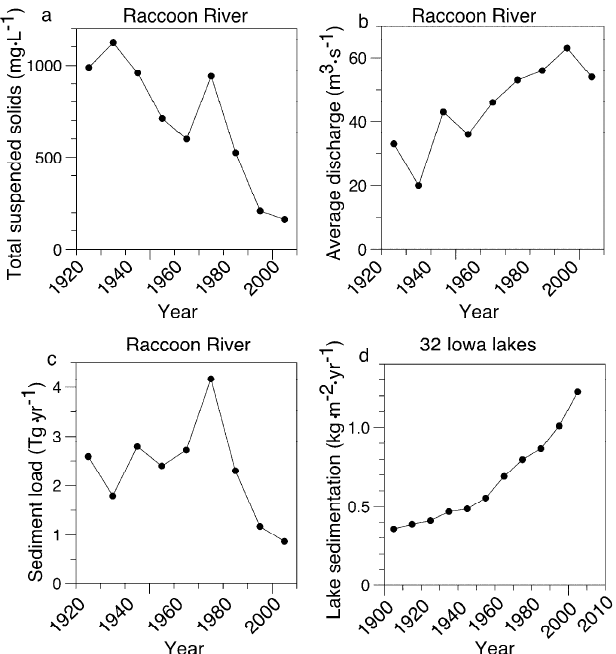
Figure 5. Decadal averages for total suspended solids ( a ), discharge ( b ) and sediment loads ( c ) (1 Tg = 10 12 grams) from 1916 to 2009 in the Raccoon River, Iowa. Data are from Jones and Schilling [20]. Decadal geometric means for lake dry sediment accumulation rates ( d ) based on 210 Pb dating of sediment cores from 33 Iowa lakes using data from Heathcote et al. [11]. Table 3. Estimated annual sheet and rill erosion (kg · m − 2 · yr − 1 ) on non-federal rural land in Iowa. Data from United State Department of Agriculture [21] and recalculated from English units.